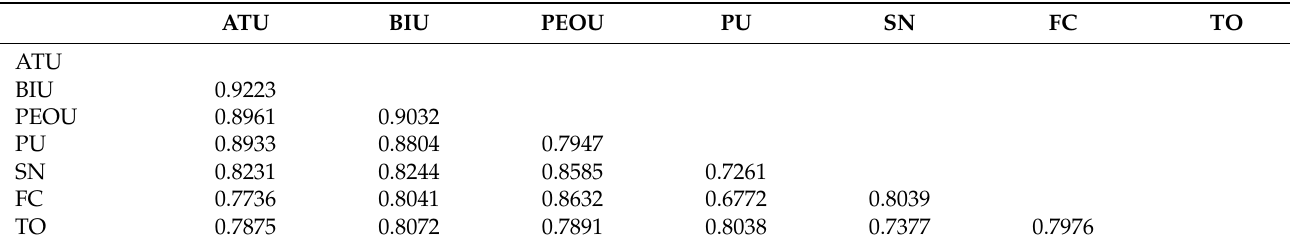
Table 4. Heterotrait–Monotrait ratios.